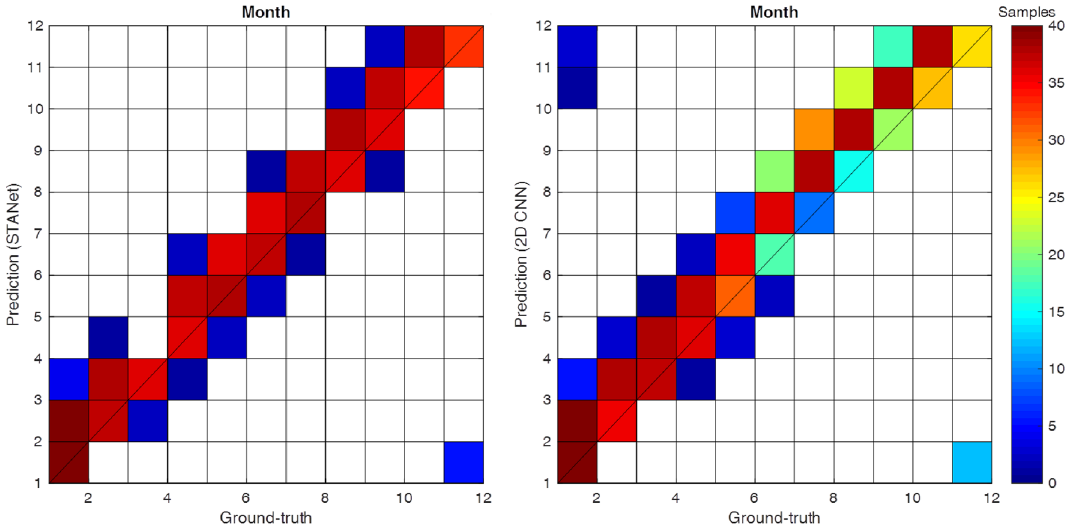
Figure 2. Density scatter of comparison between the ground-truth and the corresponding calendar month classification results from STANet (left panel) and the state-of-the-art 2D CNN model (right panel).